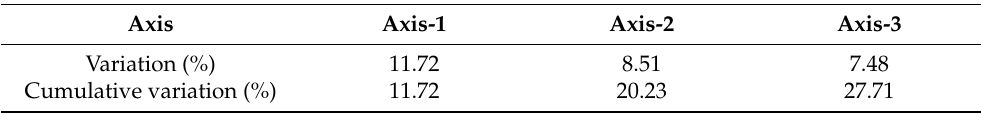
Table 3. Percentage of cumulative variation explained by the first three axes among amaranth ac- cessions in PCoA analysis .